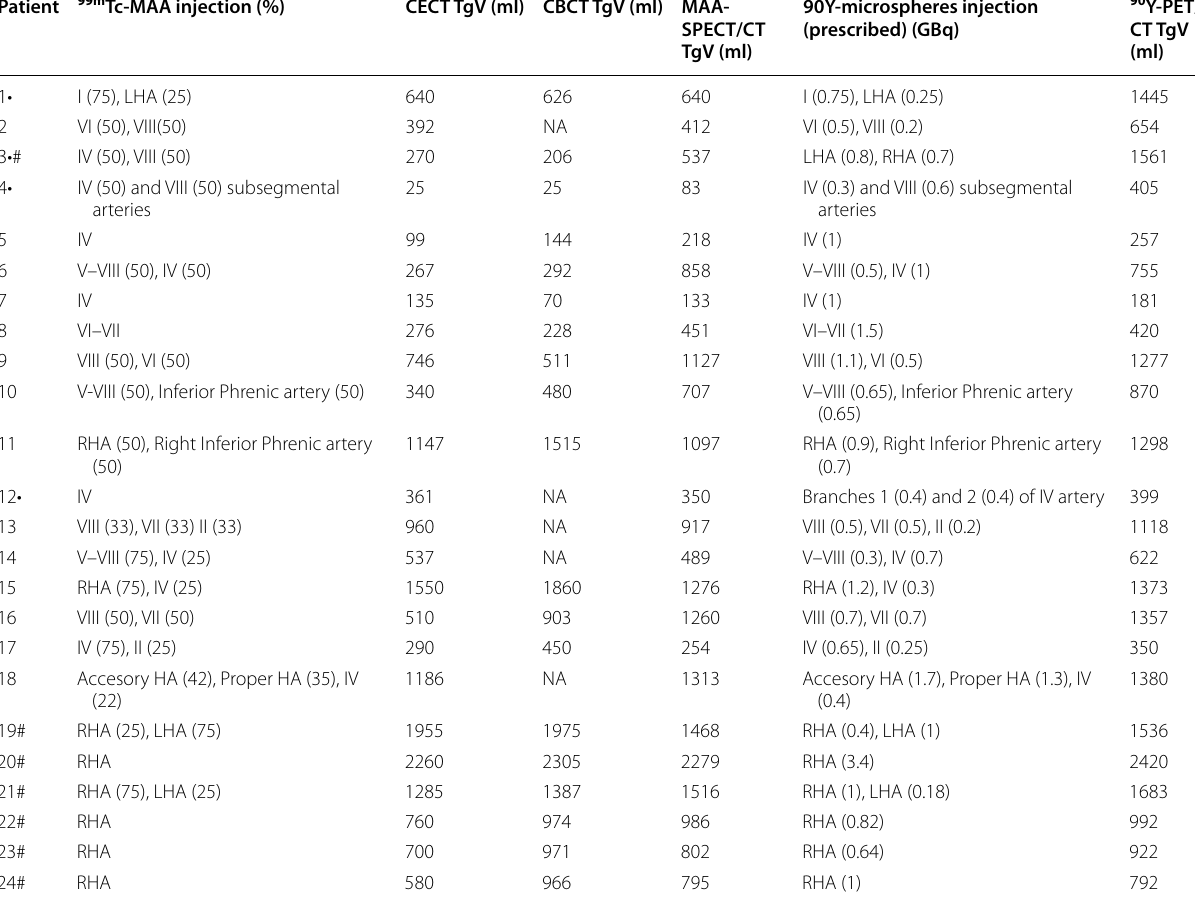
Table 1 99m Tc-MAA and 90 Y-microspheres injection sites, percentage of 99m Tc-MAA activity administered through every artery (decided by IR based on liver and tumor volumes) and split of 90 Y-microspheres prescribed by each artery (in up to 42% of patients according to CBCT volumetric